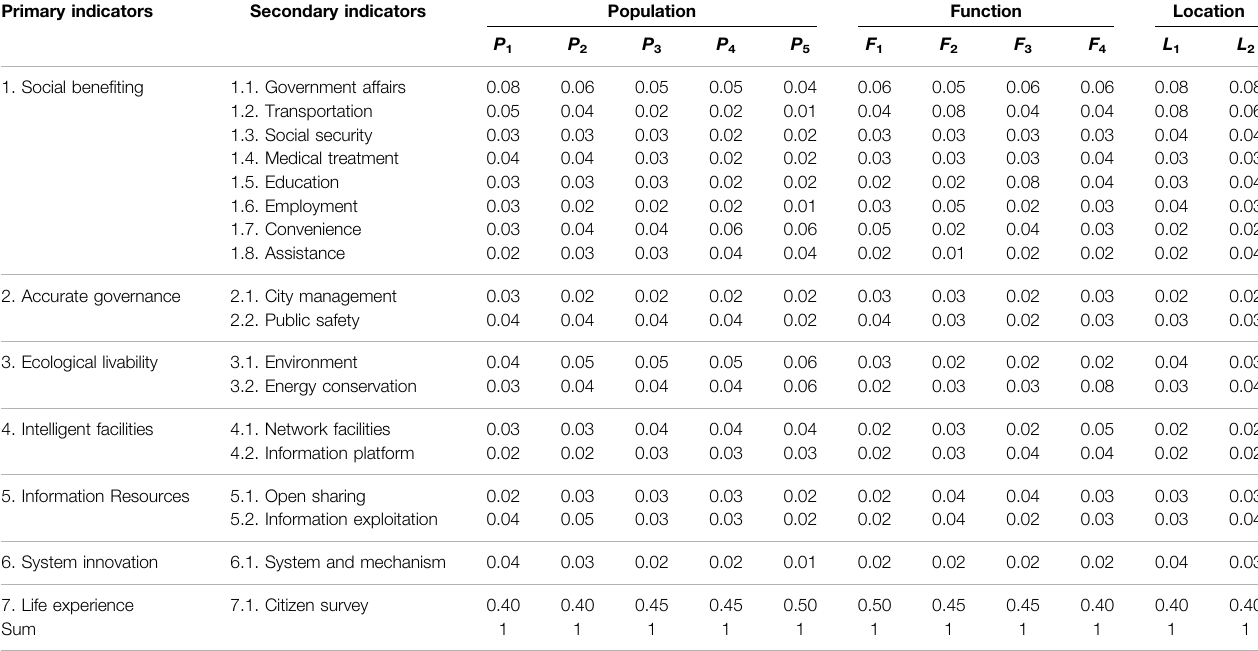
TABLE 4 | Indicators and individuation weights. Primary indicators Secondary indicators